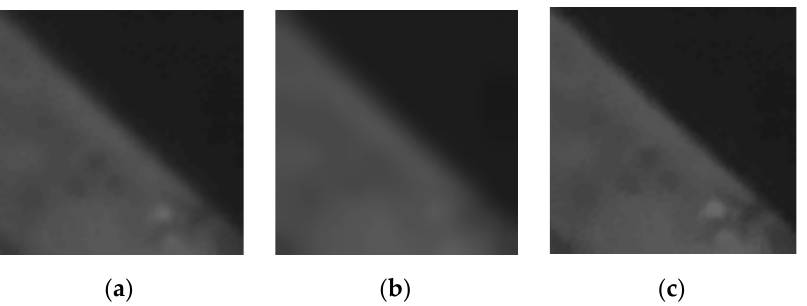
Figure 1c. It can be divided into three cases. If g ( i 0 , j 0 ) < MEAN , that is ε ( i 0 , j 0 ) < 0, the grayscale of the pixel decreases. Otherwise, if g ( i 0 , j 0 ) > MEAN , ε ( i 0 , j 0 ) > 0, the grayscale of the pixel increases. Otherwise, if g ( i 0 , j 0 ) = MEAN , ε ( i 0 , j 0 ) = 0, it becomes a conventional range filter.